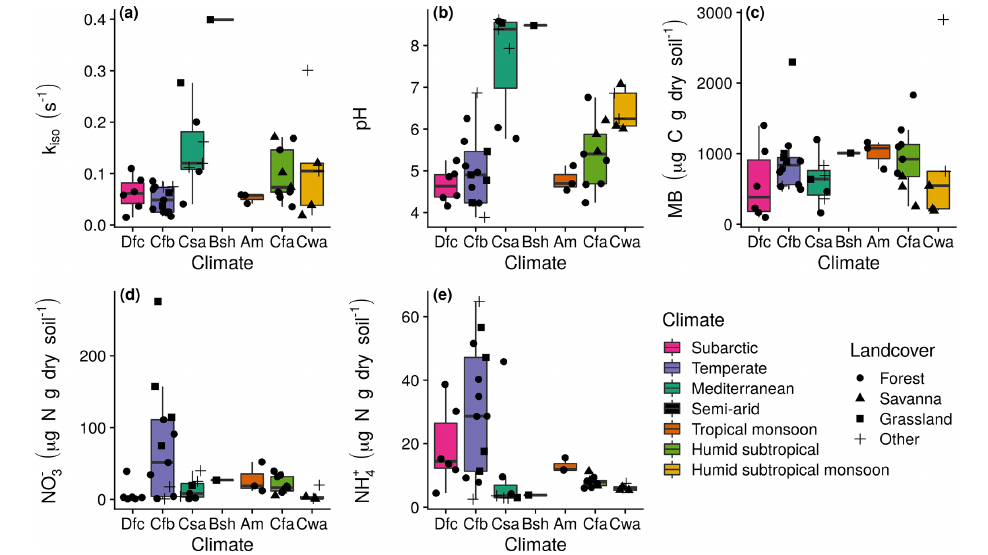
Figure 2. Measurement summaries of mean untreated soils by the Köppen–Geiger climatic zone of the sampling site. The 27 sites in western Eurasia (EUR) were within subarctic (Dfc; n = 6), temperate oceanic (Cfb; n = 13), hot-summer Mediterranean (Csa; n = 7) and hot semi-arid (Bsh; n = 1) climate zones, and the 17 sites in northern Queensland, Australia (AUS), were within tropical monsoon (Am; n = 3), humid subtropical (Cfa; n = 9) and monsoon-influenced humid subtropical (Cwa; n = 5) climate zones. Box lower, middle and upper hinges, respectively, indicate 0.25, 0.5 and 0.75 quantiles. Over-plotted points are the associated site means ( n = 2 or 3) with shape